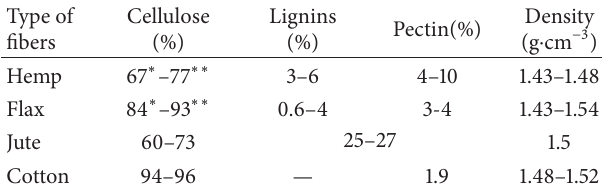
Figure 2: RC group with highly resistive and low capacitive compo- nents.